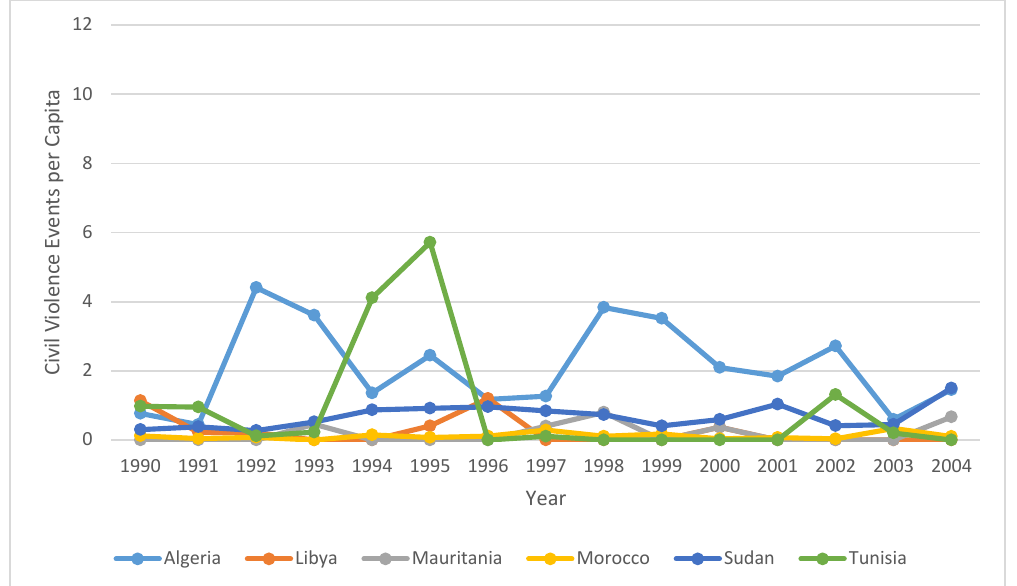
Figure 2. Civil Violence Events per Capita: North Africa, 1990–2004.